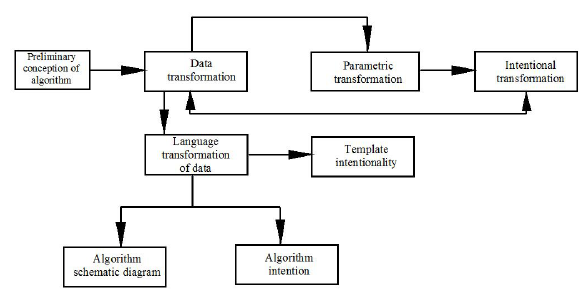
Fig. 1. Preliminary design of algorithm schematic diagram